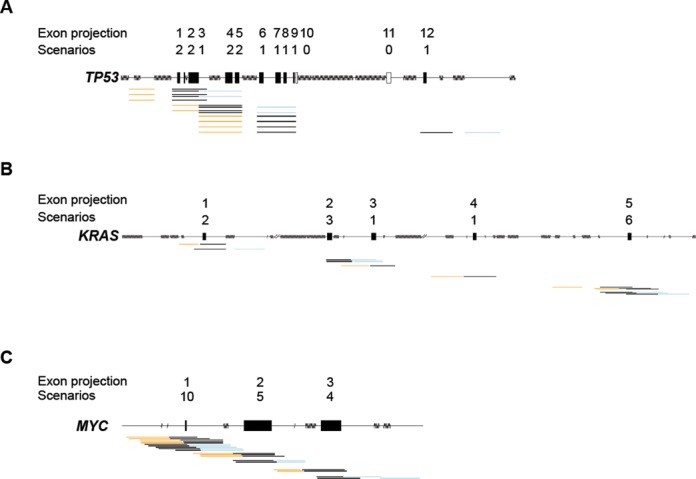
Knock-in construct designs to the cancer genes TP53, KRAS and MYC. Graphical output of potential knock-in scenarios for exon projections of TP53 (A), KRAS (B) and MYC (C) with number of scenarios per exon projection. The exon projections are represented by boxes, solid (with scenarios) or empty (without scenarios); regions with repeat sequences by a string of vertical bars; potential homology arms by horizontal lines in orange (left HA), light blue (right HA) and black (HA spanning an exon).